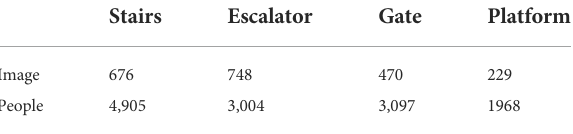
TABLE 1 Size of each subset in